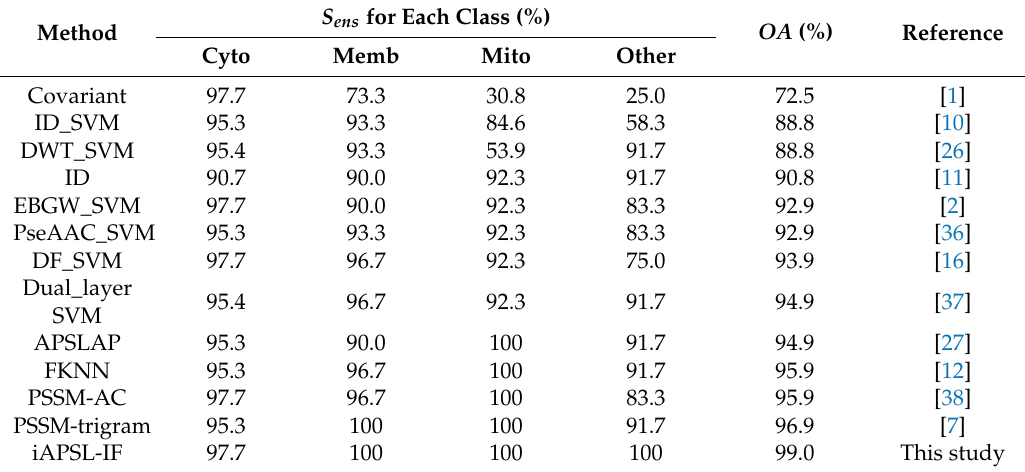
Table 2. Performance comparison of different methods on the ZD98